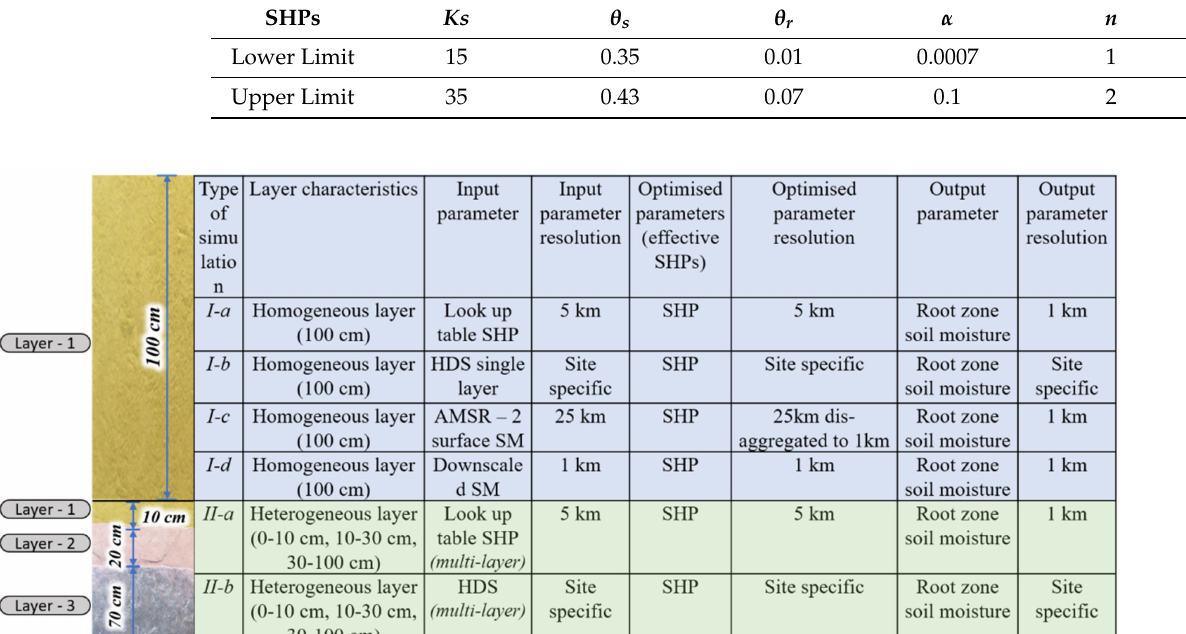
Table 1. Upper and lower limit of SHPs (range of SHPs) used in the study area. The upper and lower limits of the SHPs have been chosen to include a set of possible values of SHPs so that the simulation in HYDRUS-1D will be realistic and non-repetitive.